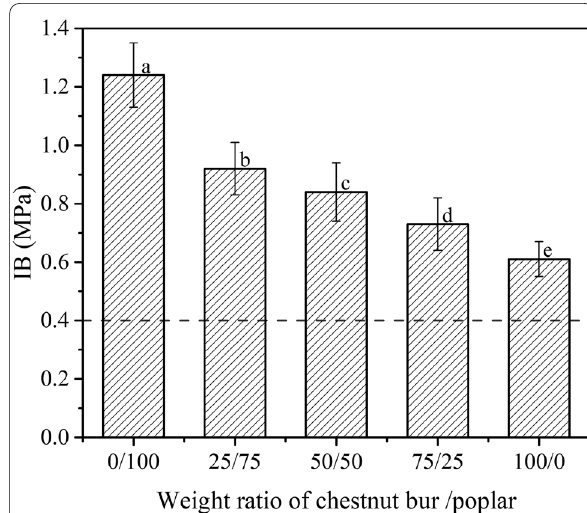
Fig. 6 Internal bond strength of composite particleboard. The effect of the weight ratio of chestnut bur/poplar on the IB of particleboard. Error bars indicate standard deviations. Different letters in the figure indicate that means are significantly different ( p < 0.05)